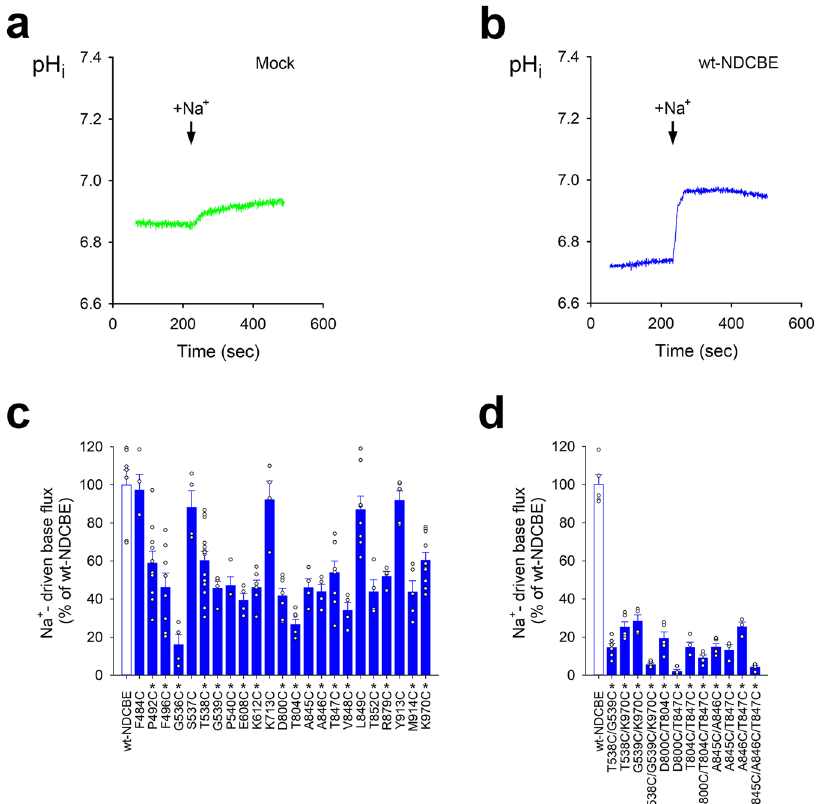
Fig. 4 Functional studies of NDCBE mutants. Typical functional traces of mock- ( a ) and wt-NDCBE ( b ) transfected HEK293 cells. c NDCBE wt ( n = 7 biologically independent experiments) and single cysteine functional mutant data: F484C ( n = 4, p = 0.9997); P492C ( n = 10, p < 0.001); F496C ( n = 8,